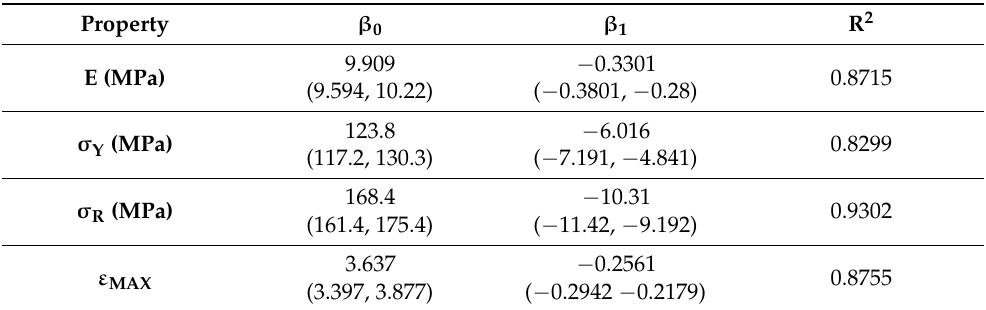
Table 5. Summary of results obtained from the linear fitting (Y = β 0 + β 1 · RN) of the experimental data. The coefficients β 0 and β 1 are accompanied with their 95% confidence bounds.